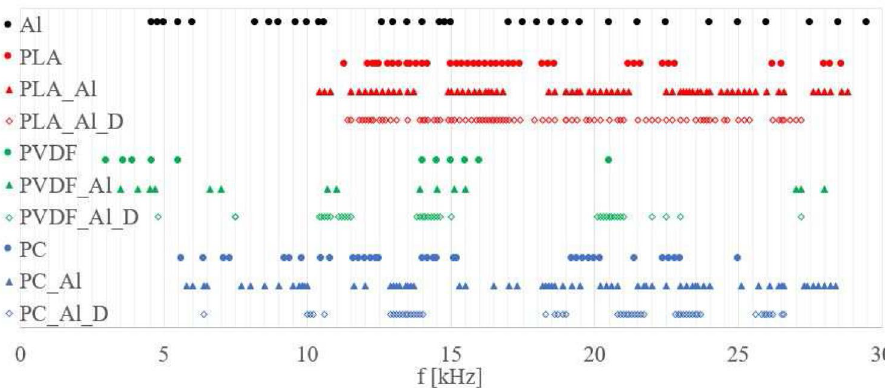
Figure 4. Frequencies for which Lamb-waves could be observed for aluminium and polymer only samples and laminates without and with a